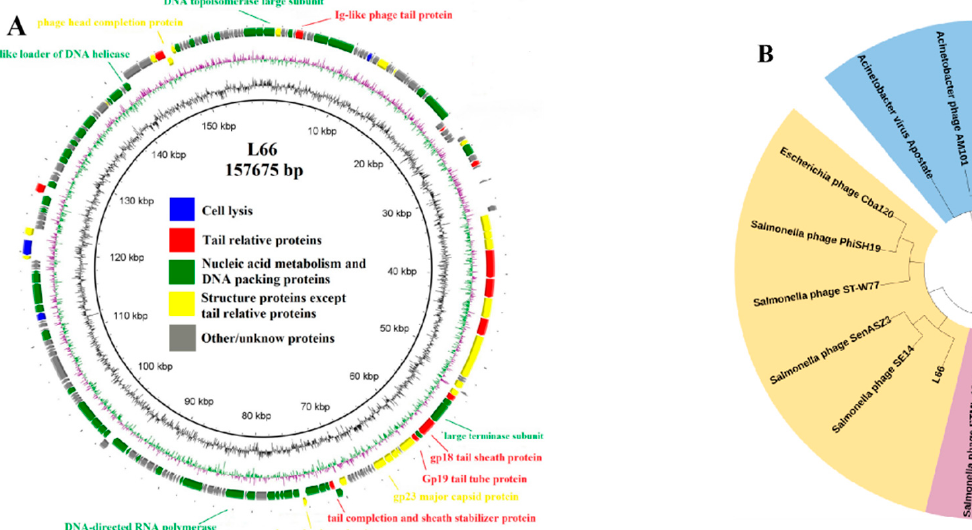
Figure 2. Analysis of phage L66 genome. ( A ) Comparative circular genome map generated using BRIG Tool. The meaning of each circle from inside to outside: (1) Gene scale in bp; (2) GC content; (3) GC offset (offset value greater than zero is green, less than zero purple); (4) Genes located on the positive strand; (5) Genes located on the negative strand. ( B ) Phylogenetic analysis based on the terminase large subunit sequences from 18 phages using MEGA 7. Four clusters are indicated by blue, pink, purple, and yellow, respectively.